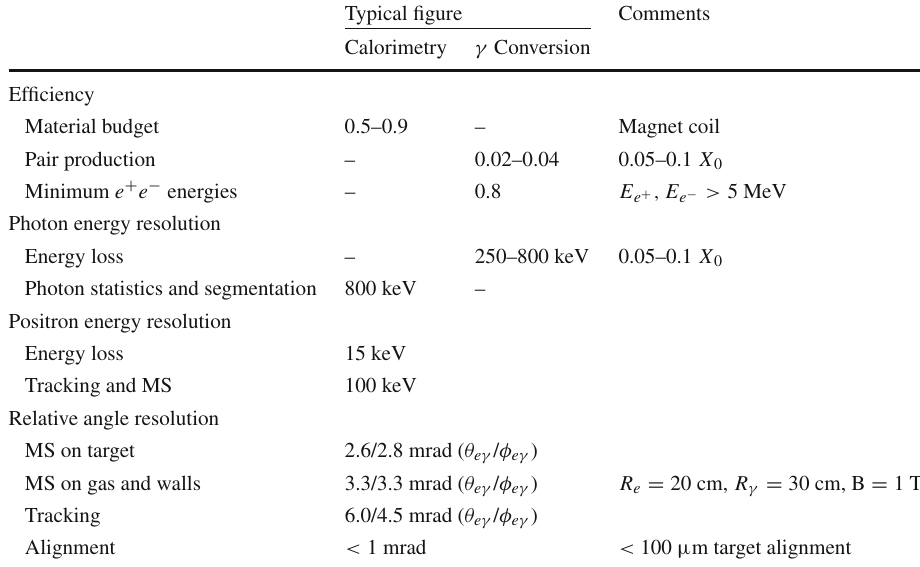
Table 4 Limiting factors for the efficiency and resolutions of future μ + → e + γ